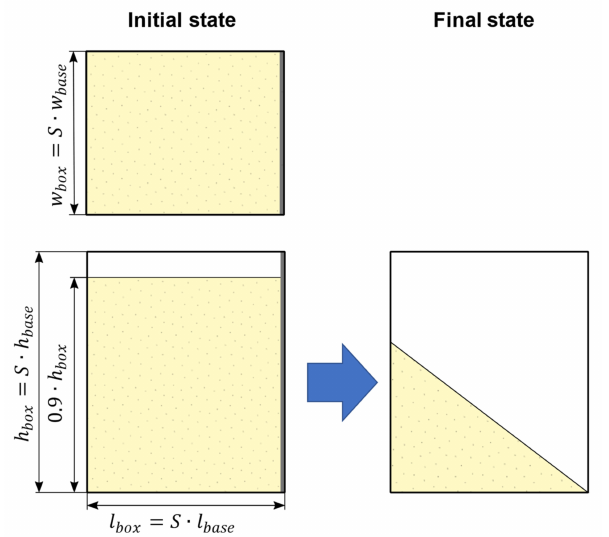
Figure 5. Structure of the shear box test: ( left ) initial state before opening the flap; ( right ) final